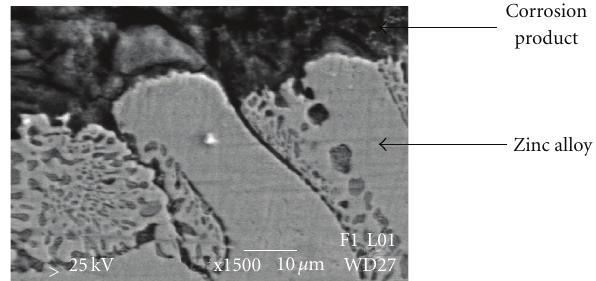
Figure 4: Surface morphology of Zn alloy after anodic polarization in 0.3M NaCl solution at T = 25 ◦ C.